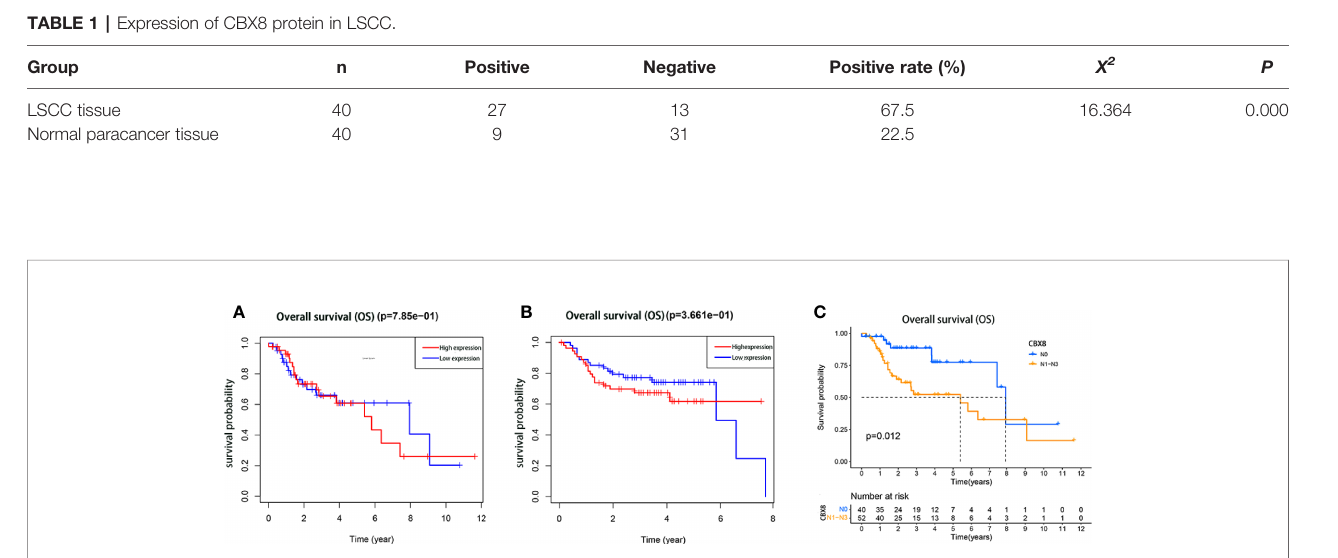
FIGURE 2 | The relationship between the expression of CBX8 protein and the prognosis of patients with LSCC. Kaplan – Meier survival curve comparison of high and low expression of CBX8. (A) Kaplan – Meier analysis of TCGA samples. (B) The Kaplan – Meier analysis of the GEO (GSE27020)samples. (C) The Kaplan – Meier analysis of the TCGA samples with or without lymph node metastasis.